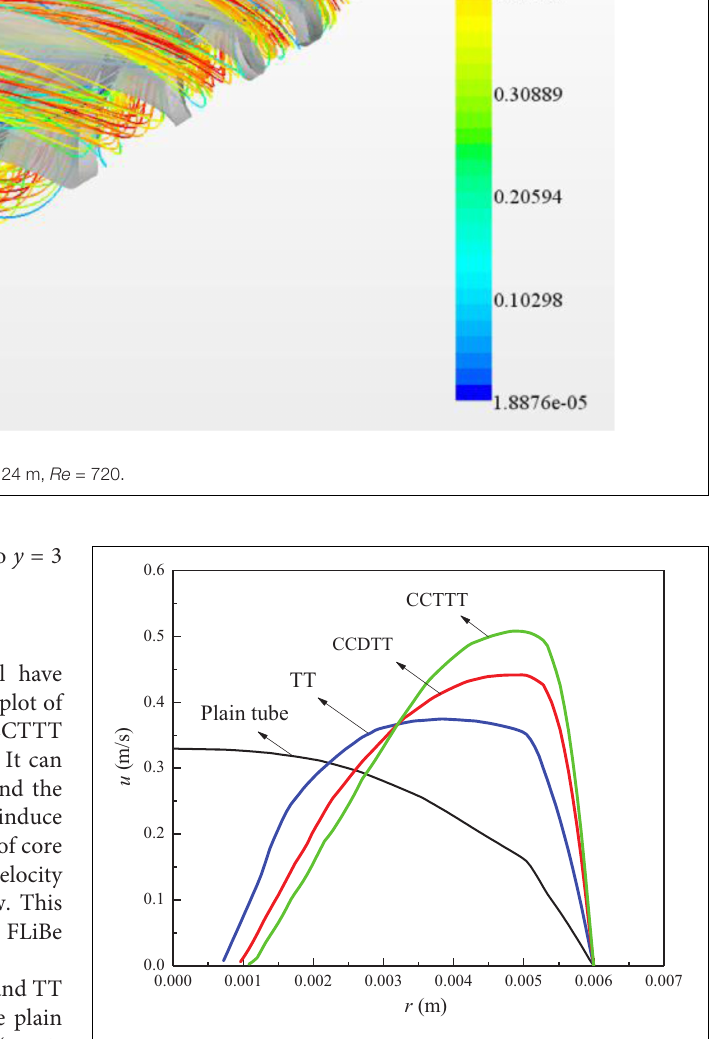
FIGURE 3 | The velocity profile of FLiBe in the plain tube and the tube fitted with TT, CCDTT, and CCTTT ( y = 3) at l = 0.24 m, Re =